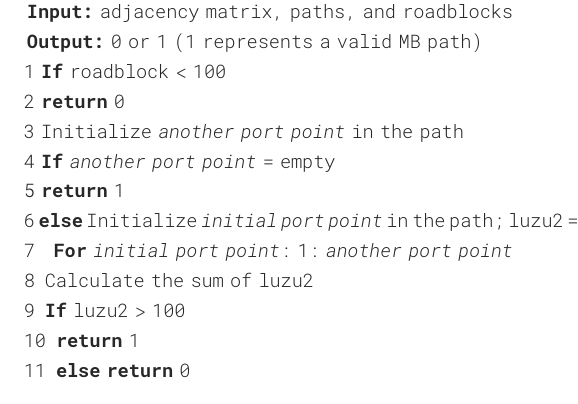
Algorithm 2: MB judgment in the fault current